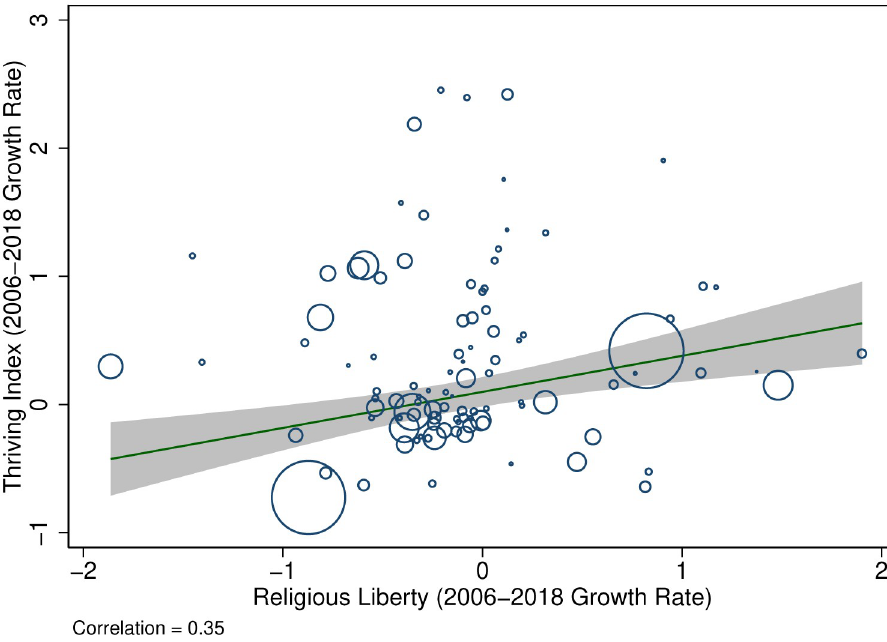
Fig 1. Motivating evidence on religious liberty and human flourishing. Sources: Gallup World Poll, Varieties of Democracy, 2006-2018. The figure reports the population-weighted association between the 2006-2018 growth rate in religious liberty and the share of individuals who report that they are thriving. This measure of thriving is generated based on having a response of 7 or higher on a 10-point scale about current life satisfaction and having a response of 8 or higher on a similar 10-point scale about expected future life satisfaction in 5 years (see Table